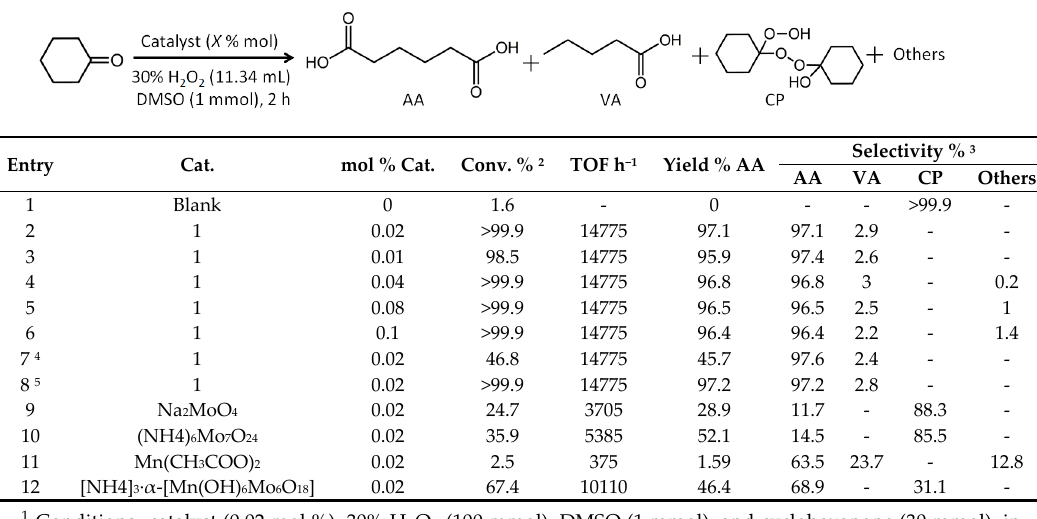
Table 1. Cyclohexanone oxidation with H 2 O 2 over catalysts. 1